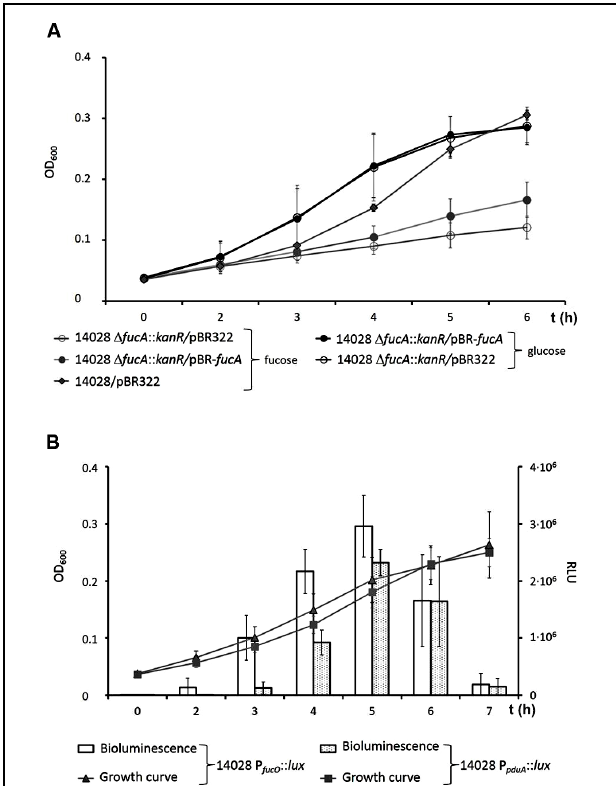
FIGURE 4 | Anaerobic growth of strain 14028 with fucose. (A) Growth curves of 14028 Nal R , 14028 (cid:2) fucA :: kan and 14028 (cid:2) fucA :: kan /pBR- fucA with either 25 mM fucose (in gray) or 27.8 mM glucose (in black). Standard deviations of three independent experiments are indicated. (B) Transcriptional activity of P fucO and P pduA was visualized by monitoring bioluminescence of 14028 P fucO :: lux and 14028 P pduA :: lux